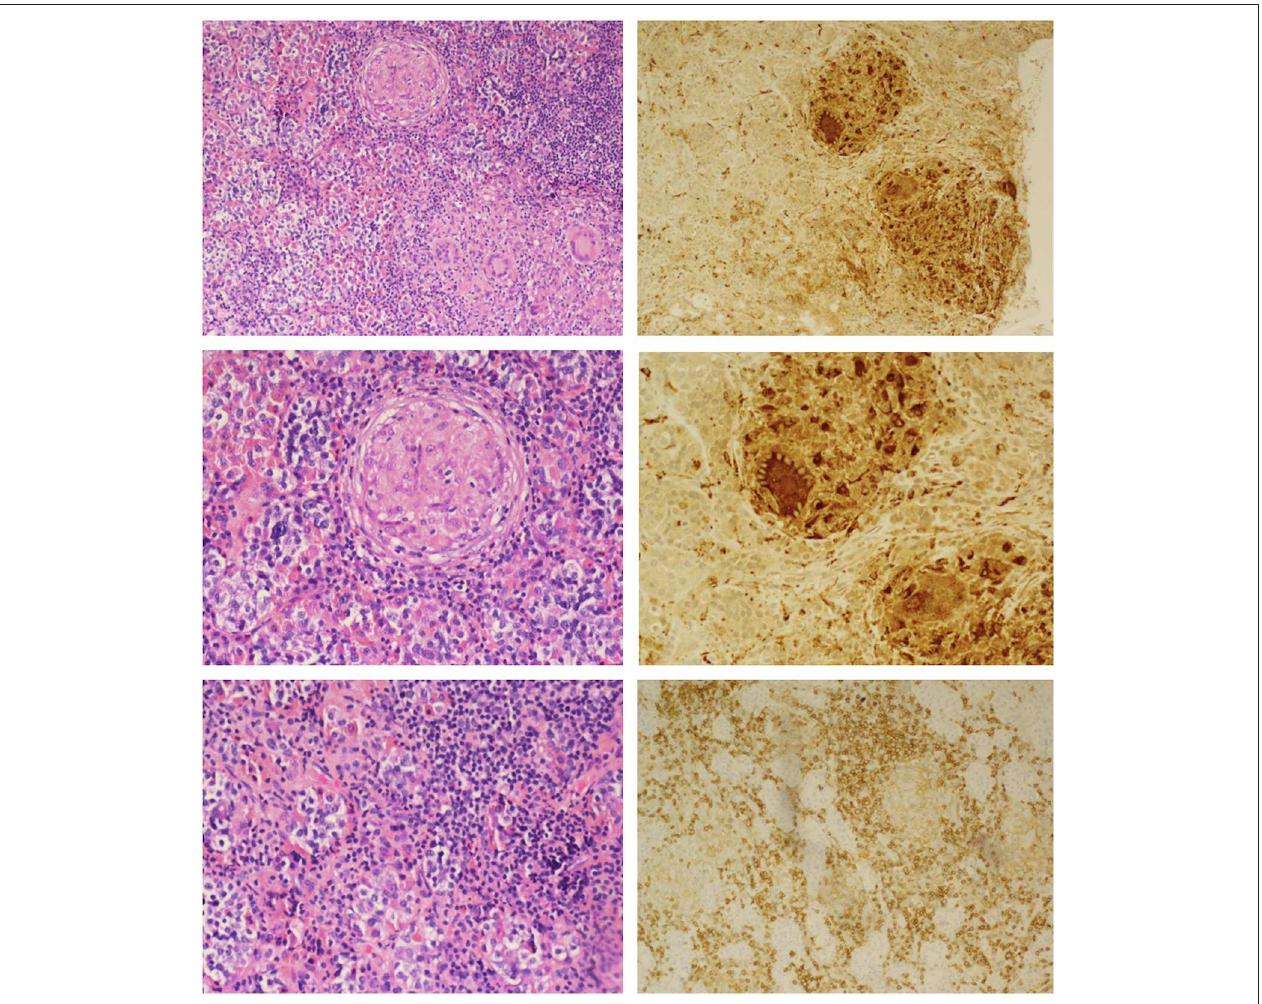
FIGURE 2 | Hematoxylin and eosin staining (Left): Upper, non-caseating granulomatous inflammation interrupting adenohypophyseal glandular cytoarchitecture; Middle, higher magnification showing multinucleate giant cells; Lower, lymphohistiocytic inflammation and fibrosis. Immunoperoxidase staining (Right): Upper and Middle, anti-CD68 macrophage marker highlighting macrophage and multinucleated giant cells; Lower, anti-CD45 lymphoid marker for